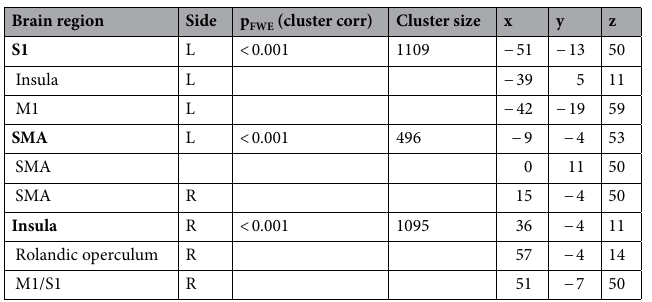
Table 2. Peak coordinates of the observed significant clusters derived from the paired t test T2 > T1. Coordinates (x,y,z) are in MNI space. L left, M1 primary motor cortex, R right, S1 primary somatosensory cortex, SMA supplementary motor